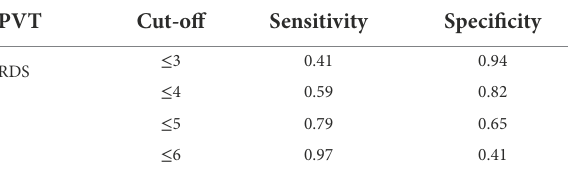
TABLE 3 RDS’ cut-off points sensitivity and specificity for older adults with dementia. PVT